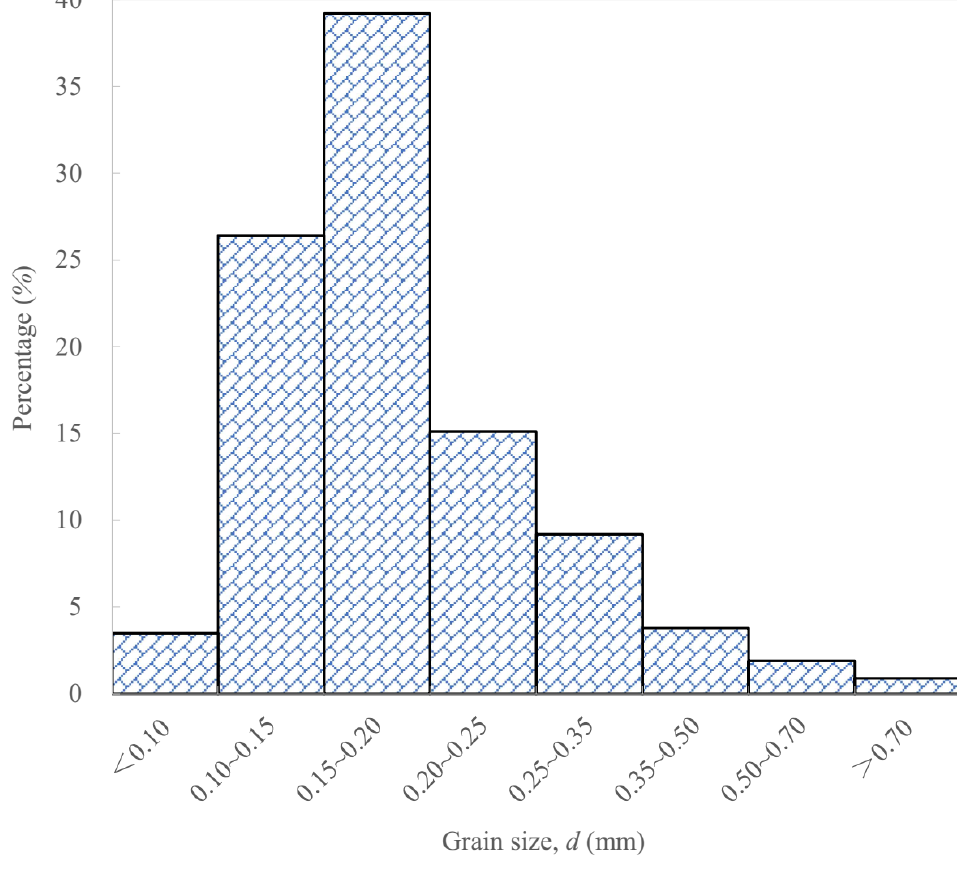
Figure 2. The grain size distribution of the sand